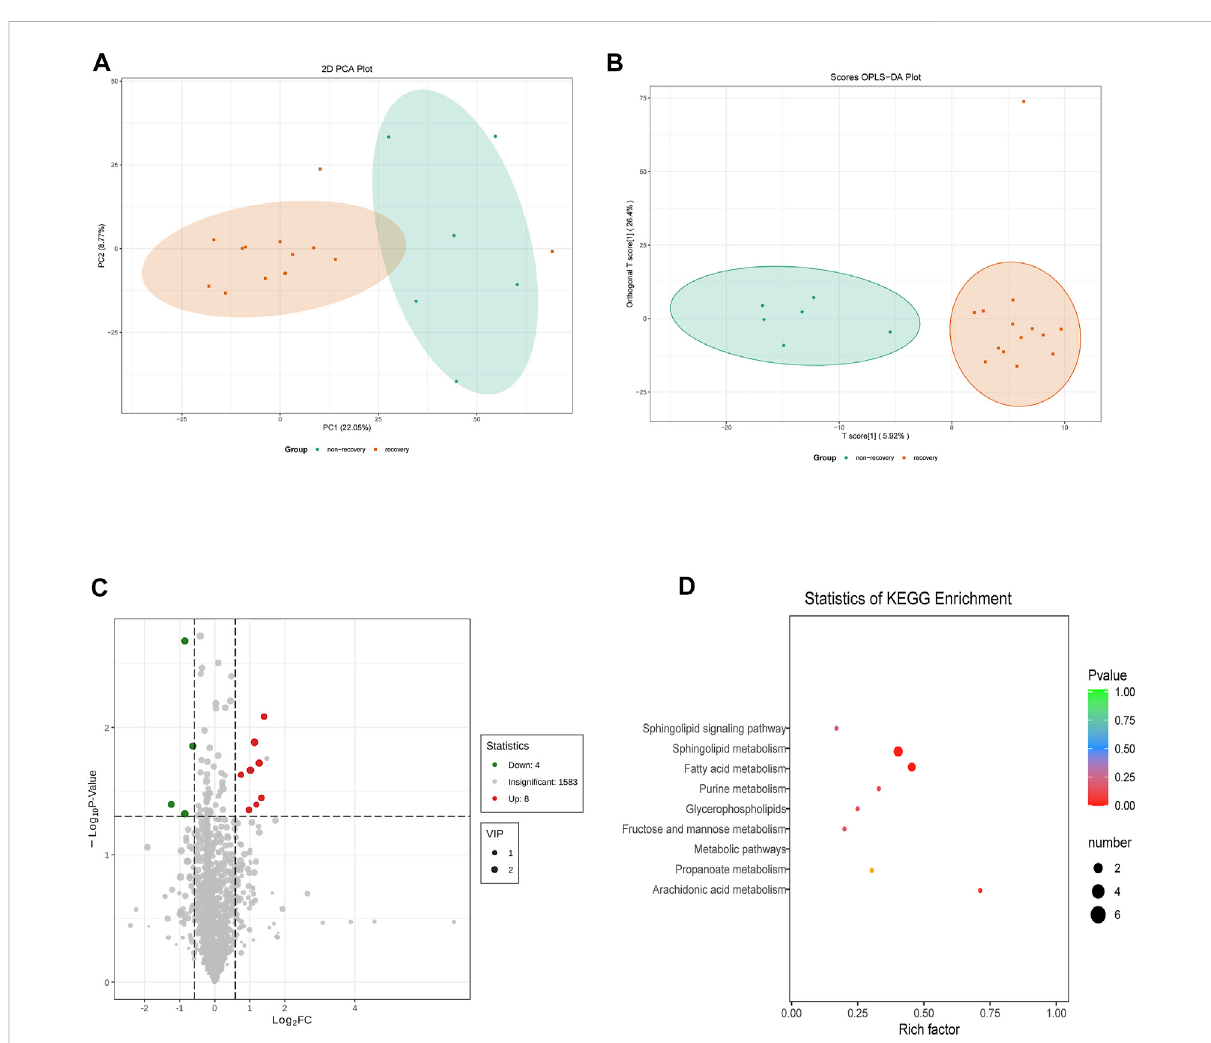
FIGURE 5 Serum metabolomicsanalysis ofsamplesfrom recovery group andnon-recovery group. (A) PCA model and (B) OPLS-DAshowingsigni fi cantly discriminative serum metabolomic pro fi le between recovery and non-recovery groups; (C) volcano plot of differentially expressed metabolites; (D) bubble plot of enriched metabolic pathways. PCA, principal component analysis; OPLS-DA, orthogonal partial least square-discriminant